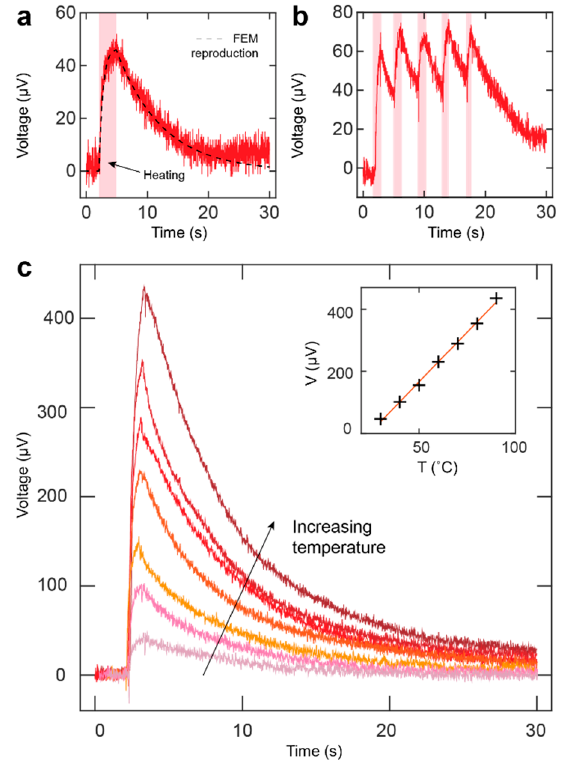
Figure 2. Transient responses of the fabricated device. ( a ) Single touch on a single channel. The duration of heating is highlighted as a shaded region. ( b ) Consecutive touches on a single channel. ( c ) Single channel responses to seven different temperatures ranging from 30 °C to 90 °C in 10 °C intervals. The inset shows the linear trend in signal peak voltages at different temperatures.